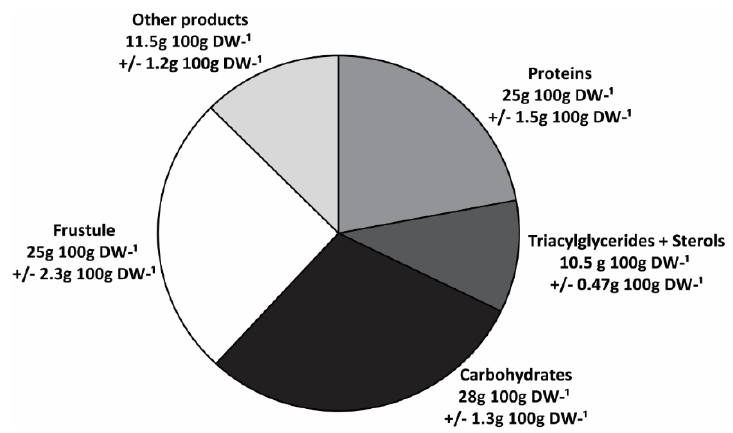
Figure 6. Biochemical profile of H. coffeaeformis . The graphic summarizes the main components found in H. coffeaeformis , expressed as considering total biomass (g 100 g∙DW −1 ).